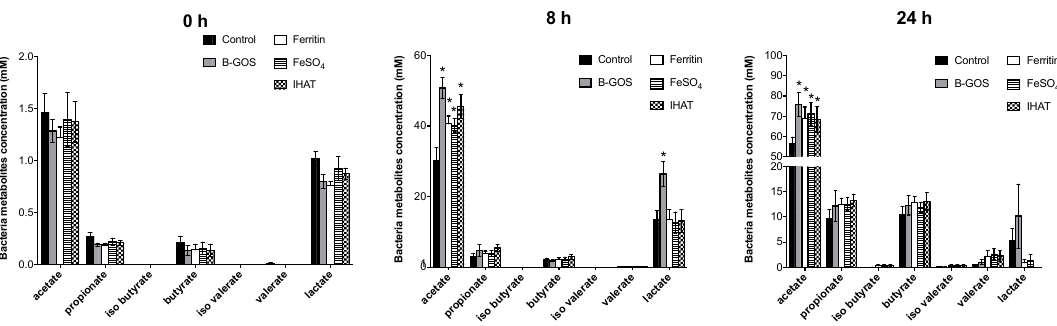
Figure 6. SCFA production at baseline (0 h), 8 and 24 h of fermentation in pH-controlled batch cultures inoculated with faeces from healthy adult donors. Values are mean ± SD of five independent experiments (five donors). *, significant di ff erences from the control condition (i.e., gut model media